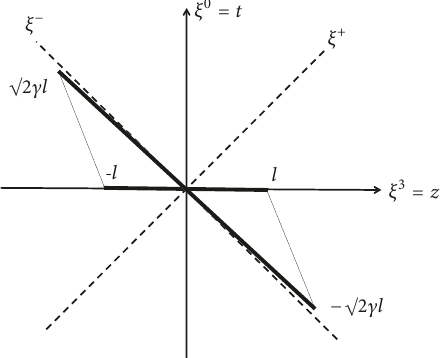
Figure 2: Schematic illustration of the relation between a finite momentum frame, with the Wilson line in a spatial direction and the light-cone frame of a hadron at rest. Due to Lorentz contraction, going to the light-cone frame increases the length by a boost factor 𝛾 , 𝛾 󳨀→ ∞ in the IMF. Source: [74], reprinted with permission by the Author and Springer